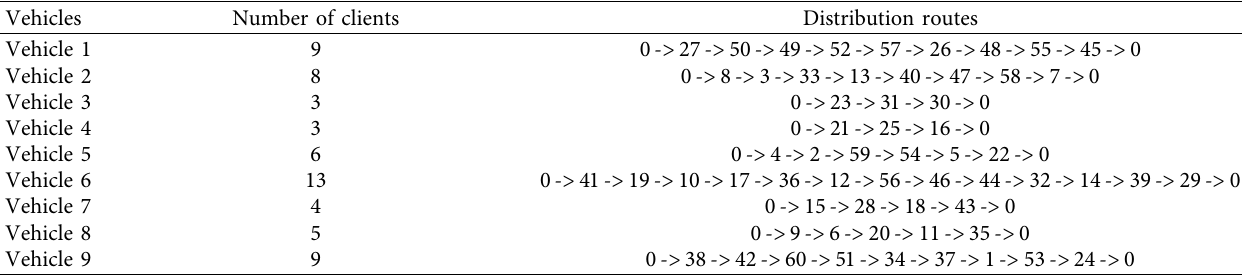
Table 5: Distribution paths from simulated annealing algorithm.